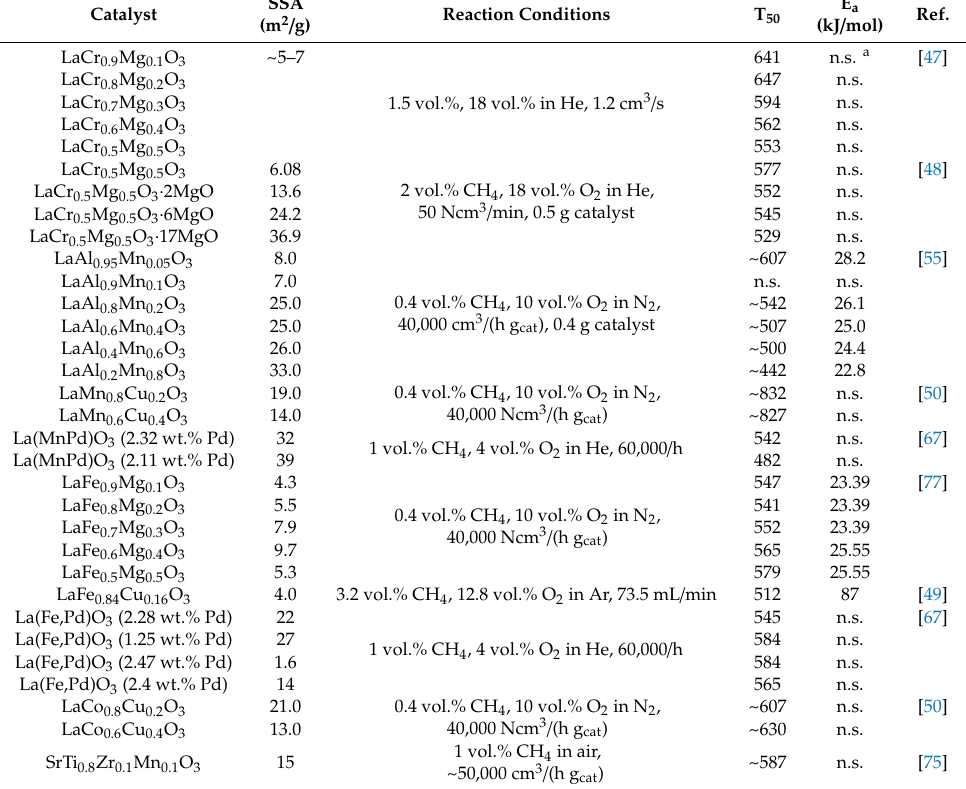
Table 11. Performances of B-site doped perovskite-type materials for the catalytic combustion of